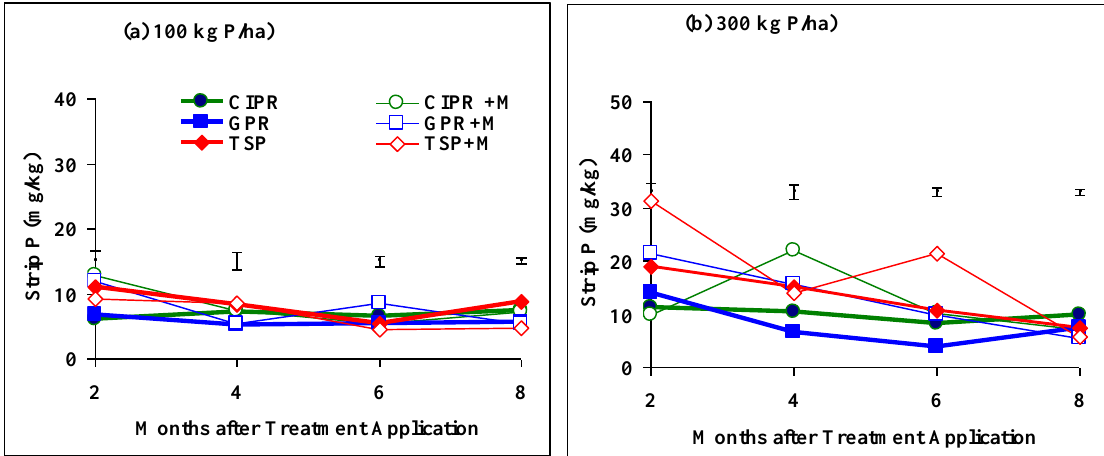
FIGURE 5. Effects of P source  manure  time on strip P release at (a) 100 kg P ha -1 and (b) 300 kg P ha -1 .